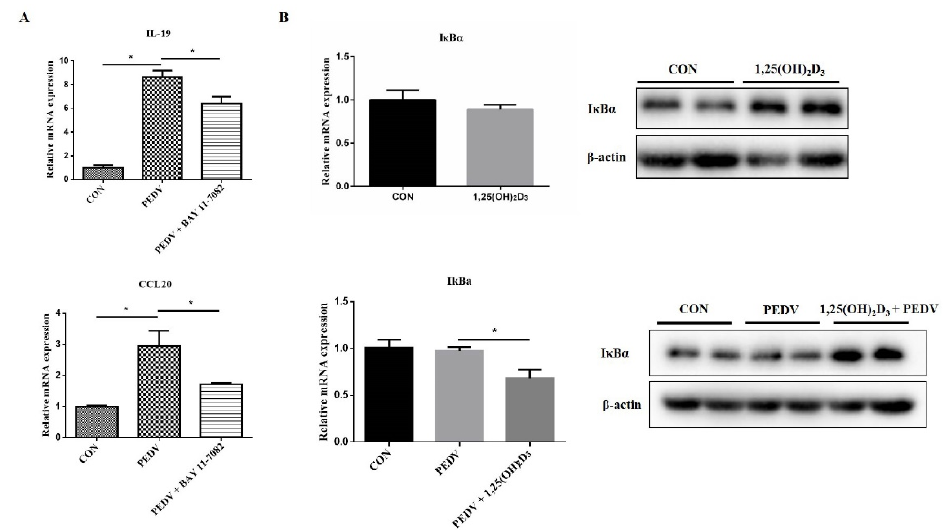
Figure 4. Effects of 1,25(OH) 2 D 3 on I κ B α expression in PEDV-infected IPEC-J2 cells. IPEC-J2 cells were infected with PEDV for 1 h, and then the cells were washed with PBS and incubated with BAY 11-7082 (10 µ M) for 24 h. After this, the cells were collected for RT-qPCR analysis ( A ). Sub-confluent cells were incubated with 1,25(OH) 2 D 3 (20 nM) for 24 h, and the cells were collected for RT-qPCR and Western blotting analysis or infected with PEDV (1 MOI). After 1 h of absorption, the cells were washed with PBS and then cultured with or without 1,25(OH) 2 D 3 (20 nM) for another 24 h. Finally, the cells were collected for RT-qPCR and Western blotting analysis ( B ). * p <